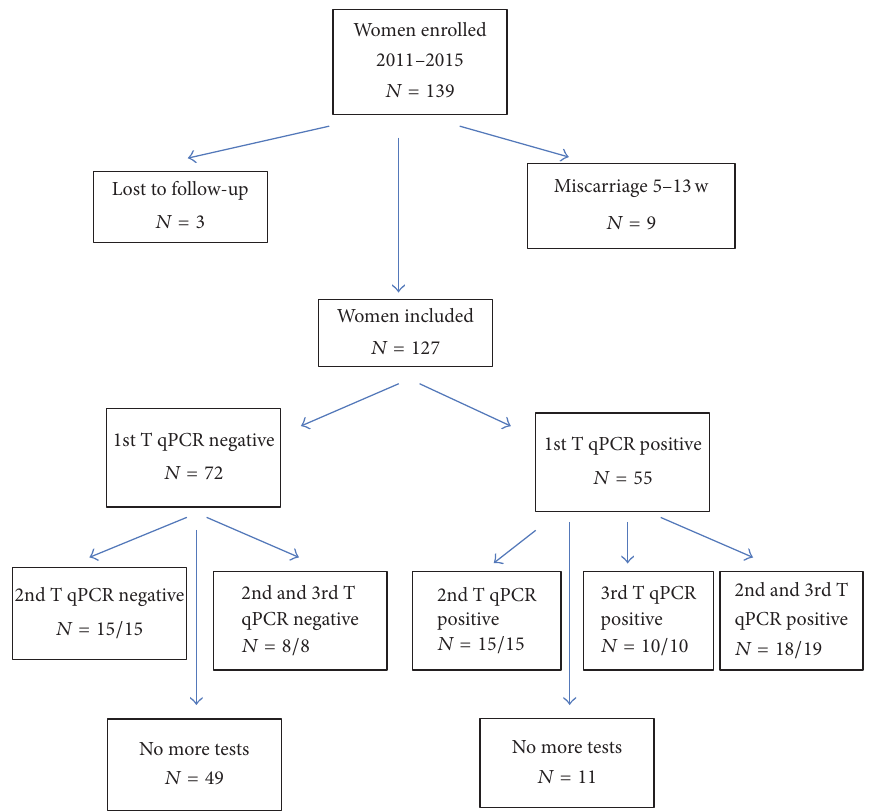
Figure 1: Enrolments of participants.